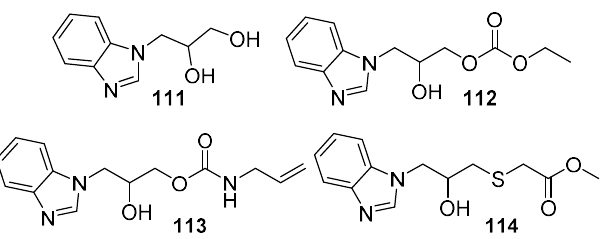
Figure 6. Products obtained from benzimidazole-derived carbonate 107 .